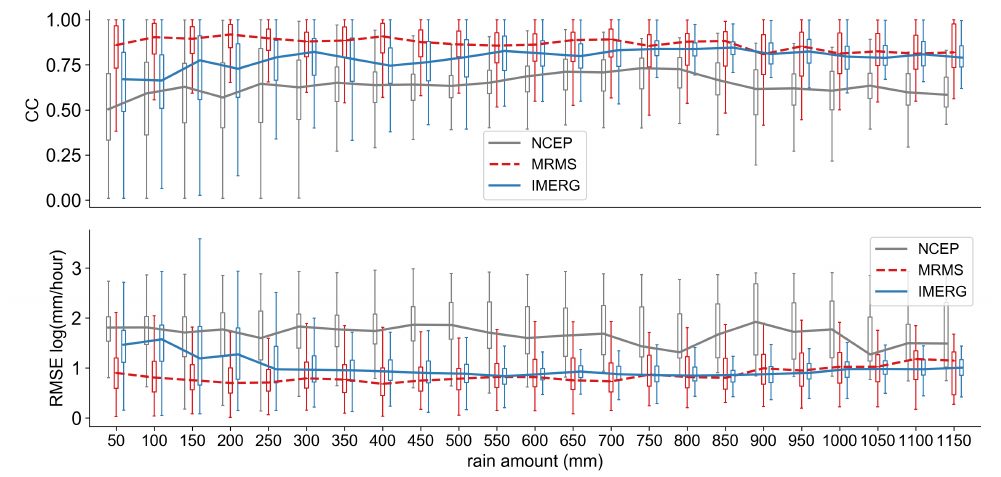
Figure 5. Boxplot of MTC measured CC, RMSE (from top down) in Hurricane Harvey at each accumulative rain bins for a 50 mm interval based on MRMS data. The lines connected the median value of each box for the corresponding product.